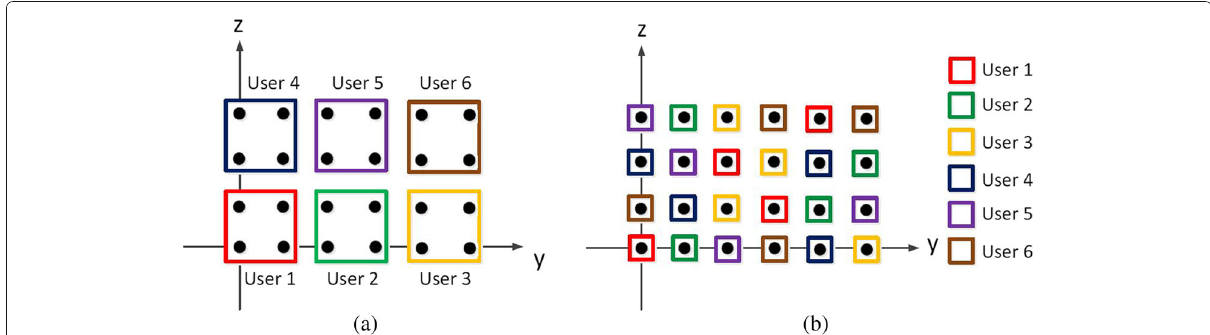
Fig. 3 The fixed and random antenna selection patterns for uniform planar array : K = 6. a Fixed patterns. b Random patterns